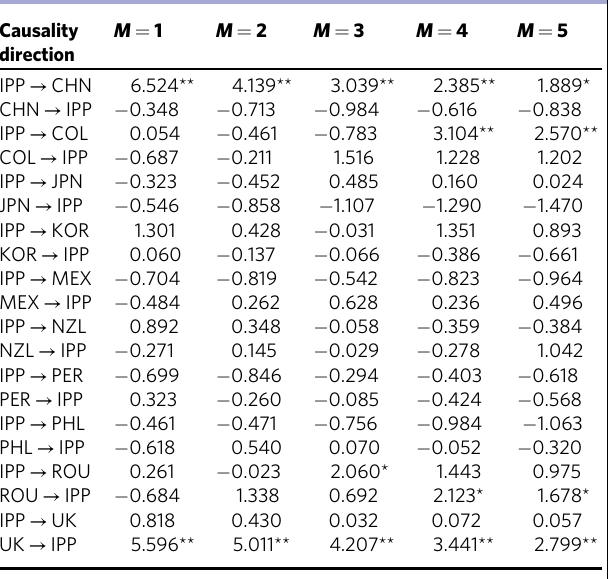
Table 7 Results for causality-in-variance test. Table 8 The model selection for DCC models.